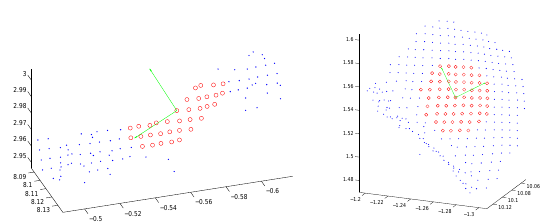
Figure 4: A subset B (red circles) is elongated (left) and this is reflected in the eigenvalues ( λ 1 , λ 2 , λ ) and eigenvectors λ 3 holds and u 1 ( u 1 , u 2 , u 3 ) of C ( B ) such that λ 1 >> λ 2 Figure 5: Classification of ground points. Left: The blue points ≥ approximates the direction B is elongated. When the eigenval- denote the cover sets L i that are initially classified as ground ues λ 1 and λ 2 are approximately equal (right), there is no clear points ( r = 0 . 03 , f g = 100 , p g = 0 . 5 ). Right: The final classifi- direction of elongatedness. cation of ground